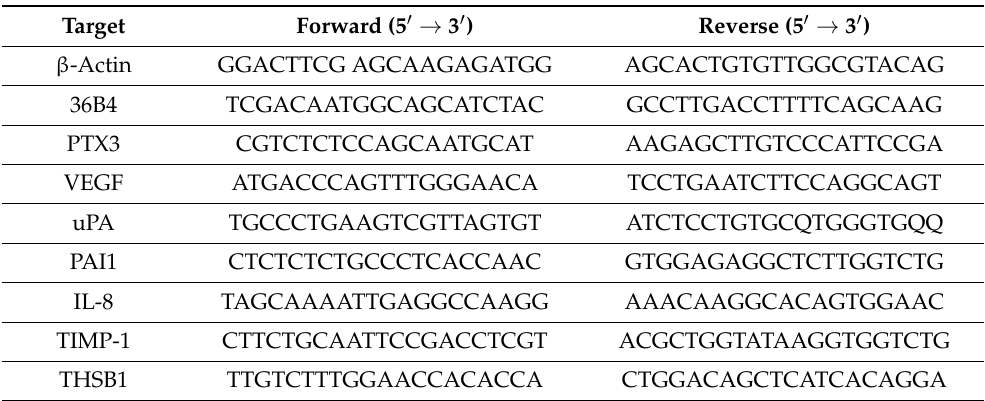
Table 2. List of primers used in the present